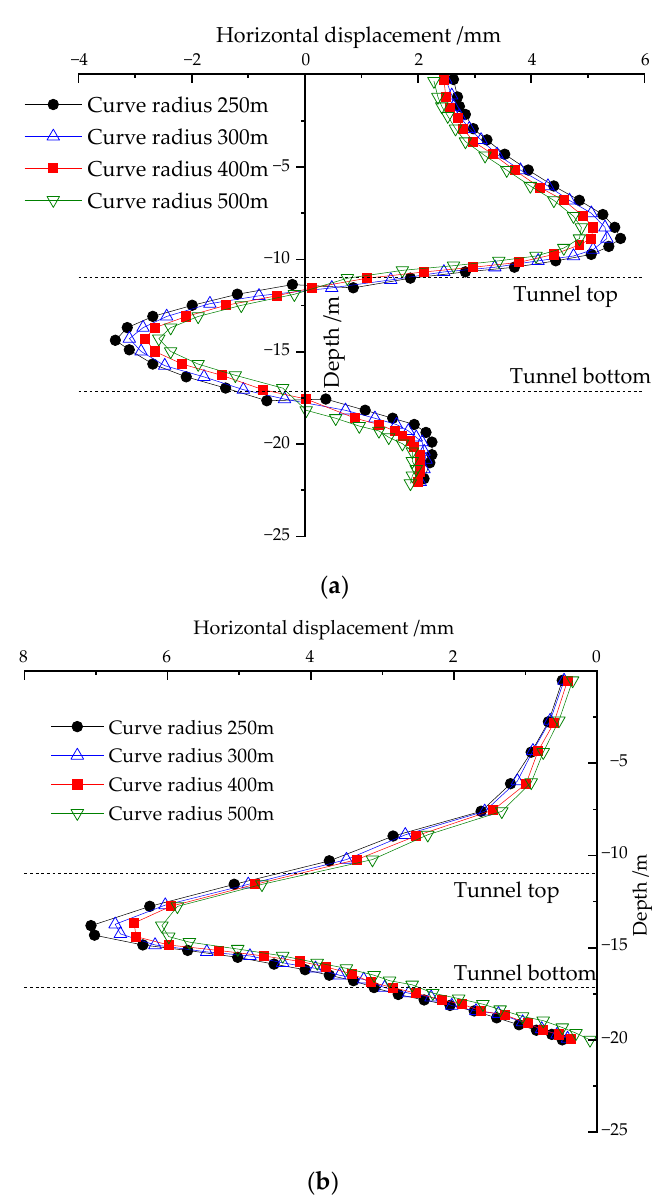
Figure 11. Curves of horizontal displacement of surrounding soil with curvature radius: ( a ) outer side of curved tunnel axis; ( b ) inner side of tunnel axis.